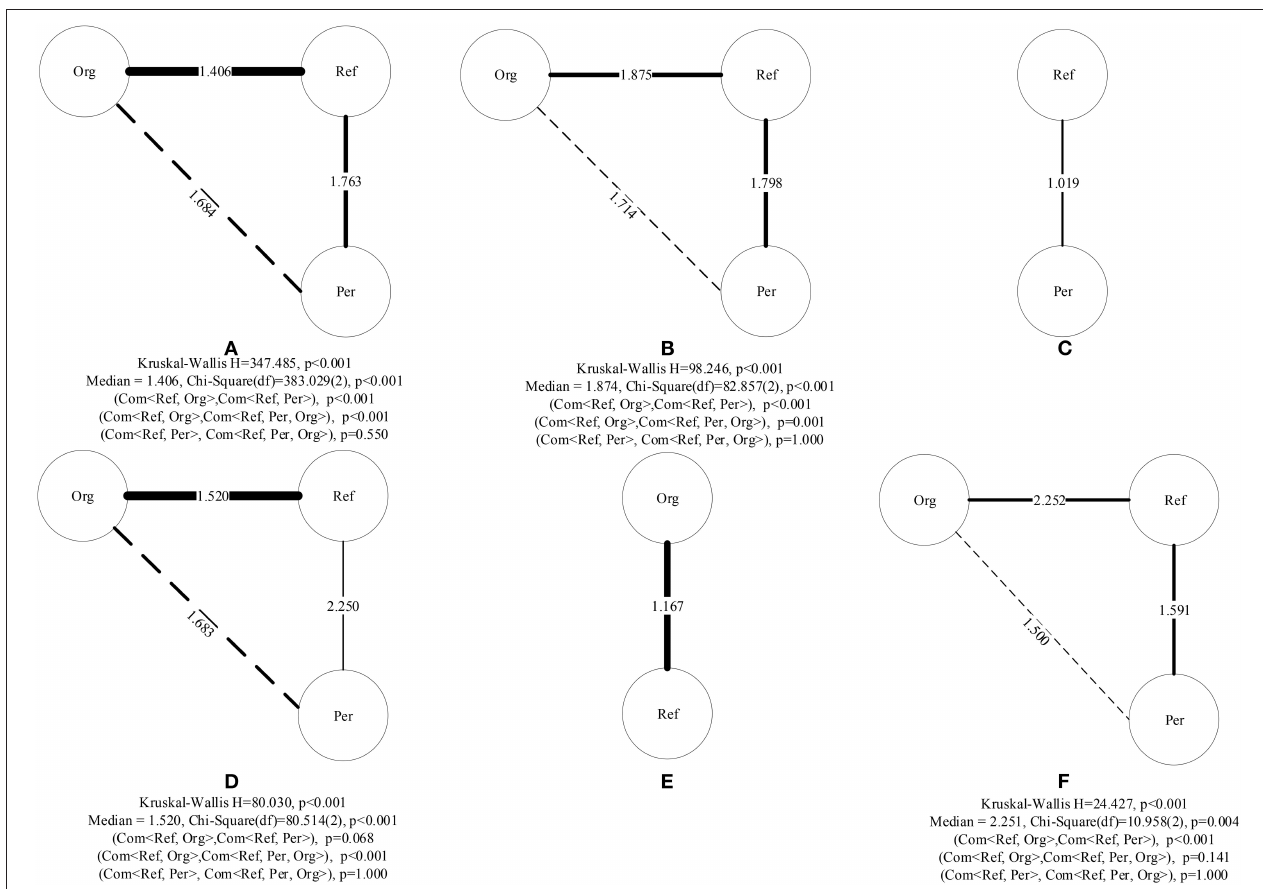
FIGURE 5 | Distribution of debunking methods in a combination method: (A) overall, (B) News rumor, (C) Jiangsu rumor, (D) PatientZero rumor, (E) Russia rumor, and (F) Car rumor. (a) Although certain combinations of methods are missing in some rumors, our study is based on available data to obtain the best combination of methods to be used for debunking rumors. (b) The p -value was the adjusted p -value, which was employed with a Bonferroni-type adjustment of p